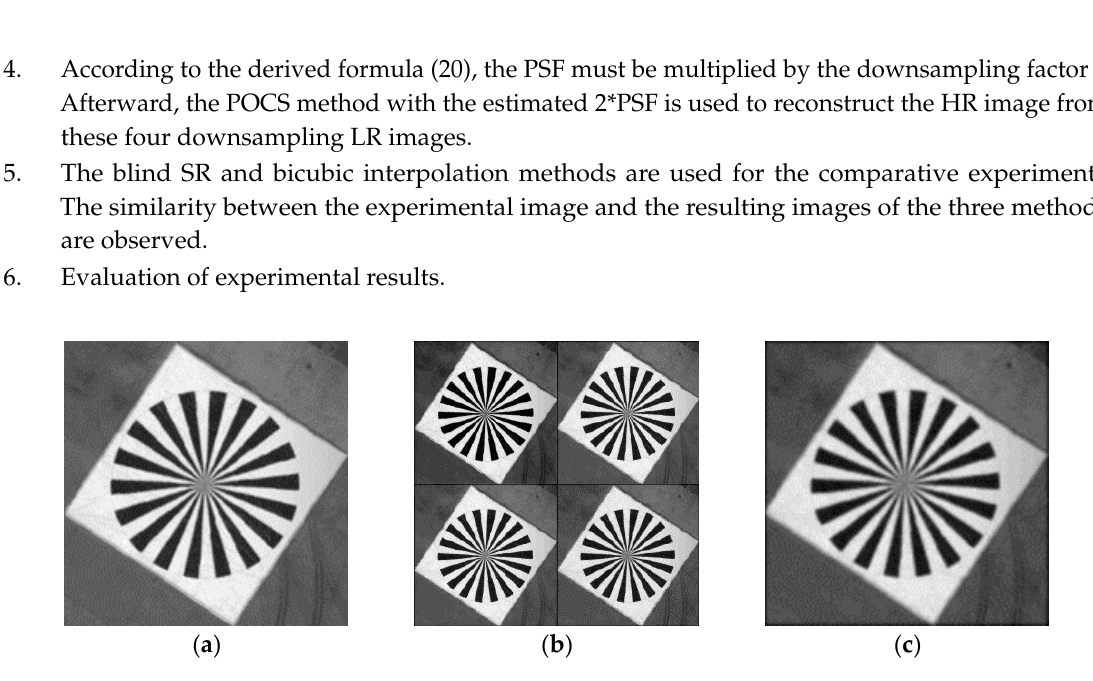
Figure 10. Simulation results. ( a ) Original image; ( b ) four simulated LR images; ( c ) one of the LR interpolated images, with the same size as that of the original image. Table 3. Transformation parameters of the simulation image.